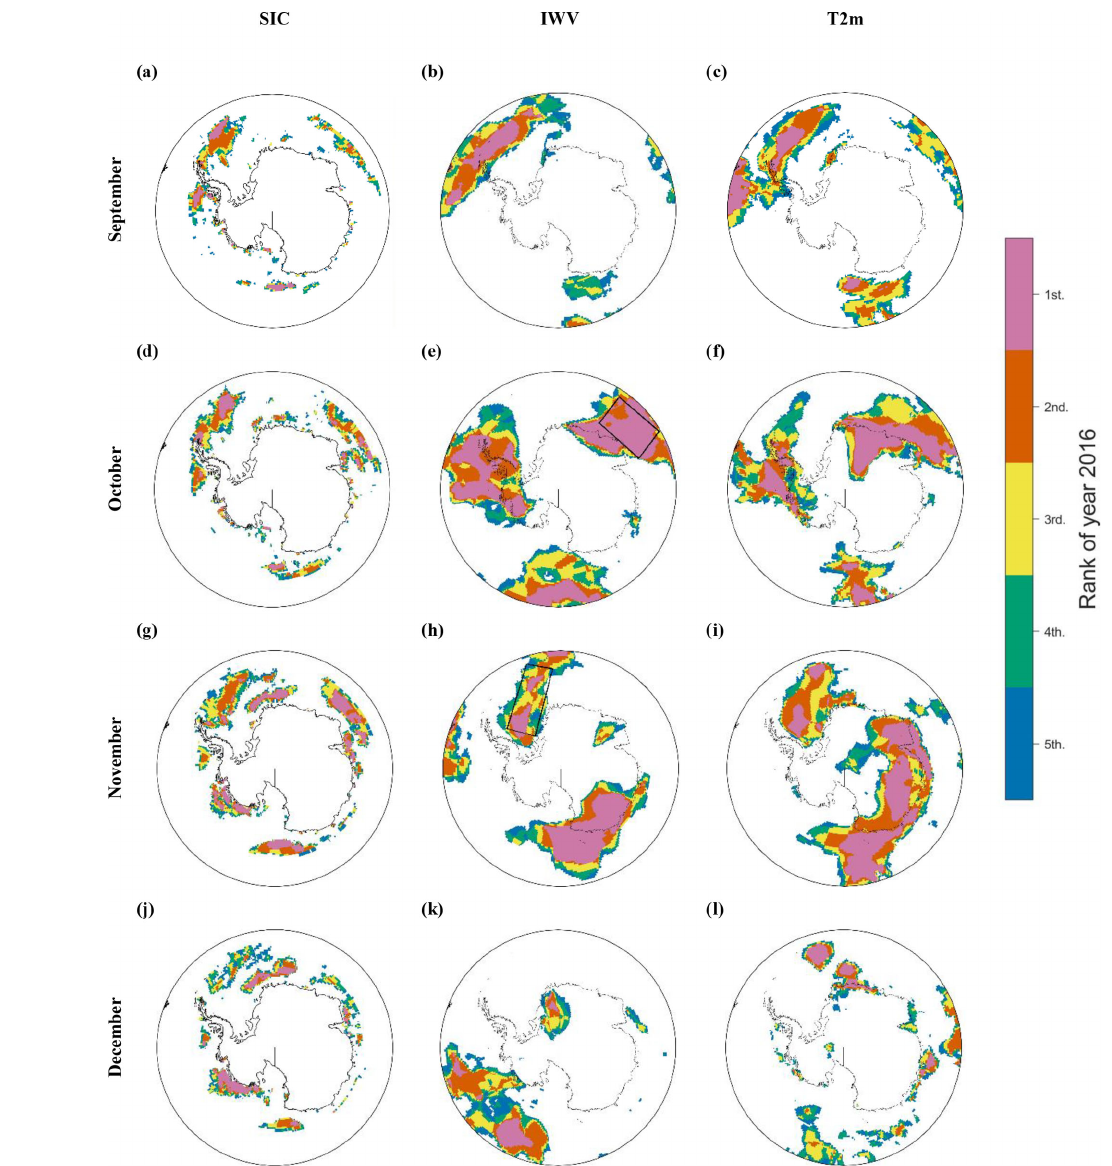
Figure 5. Ranking of 2016 monthly sea ice concentration (SIC – a, d, g, j ; “1” means lowest SIC over the analyzed period), the vertical integral of water vapor (IWV – b, e, h, k ; “1” means the moistest month over the analyzed period); 2m air temperature (T2m – c, f, i, l ; “1” means the warmest month over the analyzed period). The analyzed period is 1979–2016. Rankings below five appear